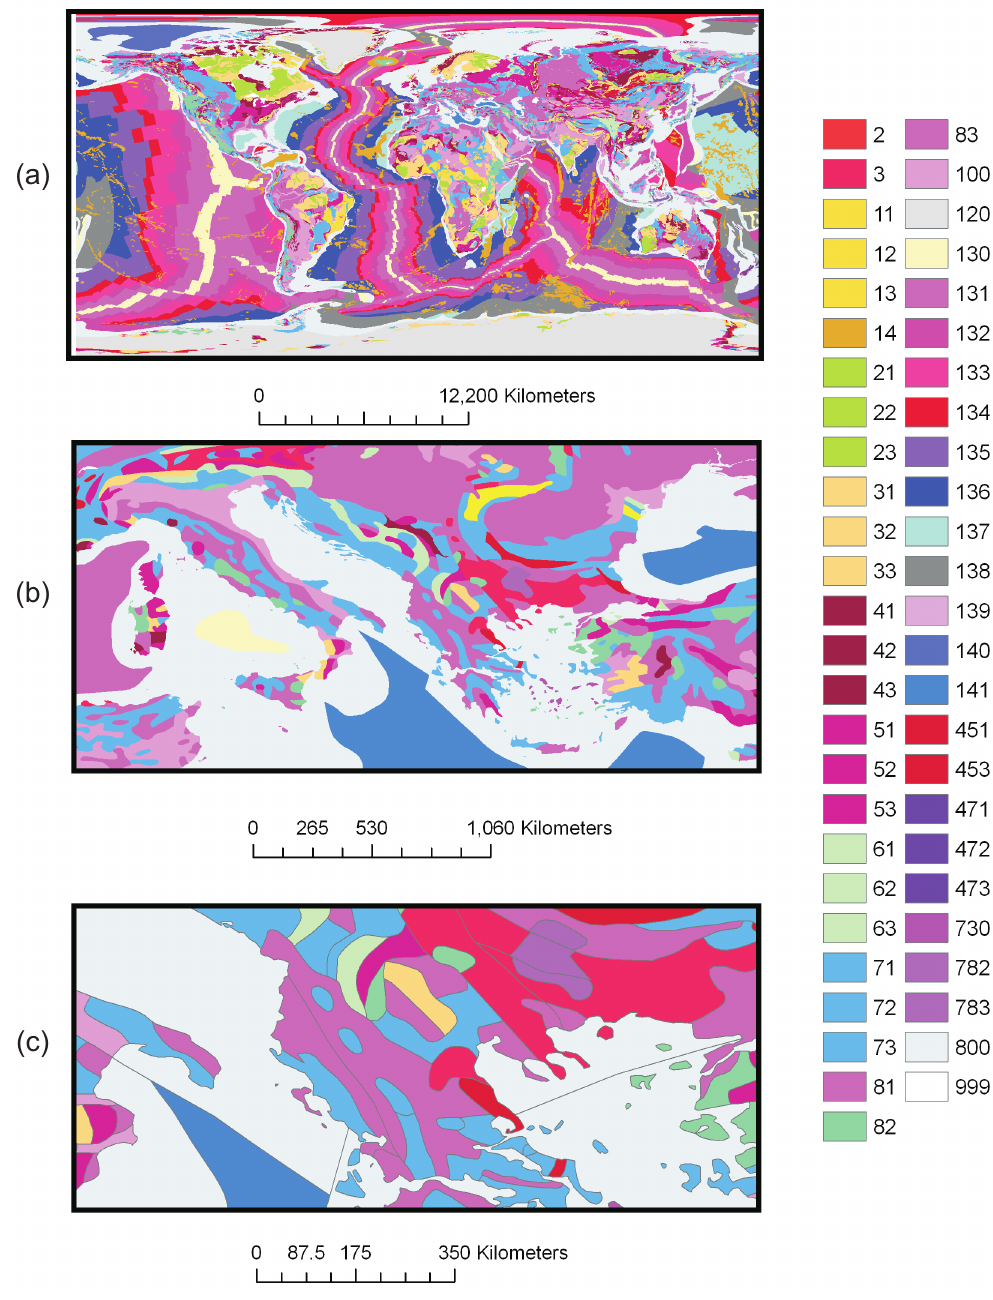
Fig. 4. Geology as given by Commission for the Geological Map of the World – CCGM (2000): (a) Global view; (b) focussed on South-East Europe; (c) focussed at higher-resolution in South-East